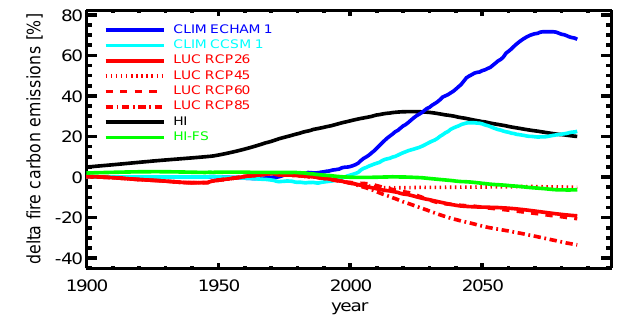
Fig. 3. Change in global annual mean fire emissions 1900 to 2100 in [%] introduced by different forcings: climate: ECHAM/MPI- OM (CLIM ECHAM 1, Roeckner et al., 2006) in blue and CCSM (CLIM CCSM 1, Meehl et al., 2006) in light blue, respectively; harvest/land use change in red for RCP 26, 45, 60, and 85, respec- tively; human ignition in black; human ignition and fire suppression in green. Simulations with transient varying forcings are compared to a control simulation in which the forcing is kept constant. The difference in percentage is calculated relative to the control simu- lation. The timeseries were smoothed with a 25yr running